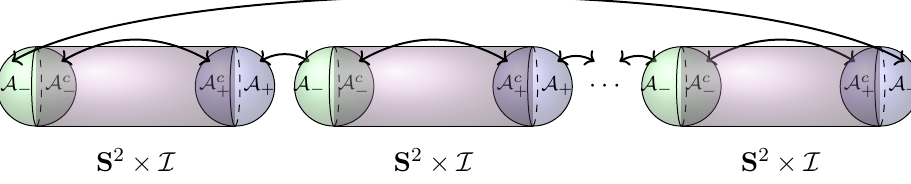
(cid:26) is represented by the path b A